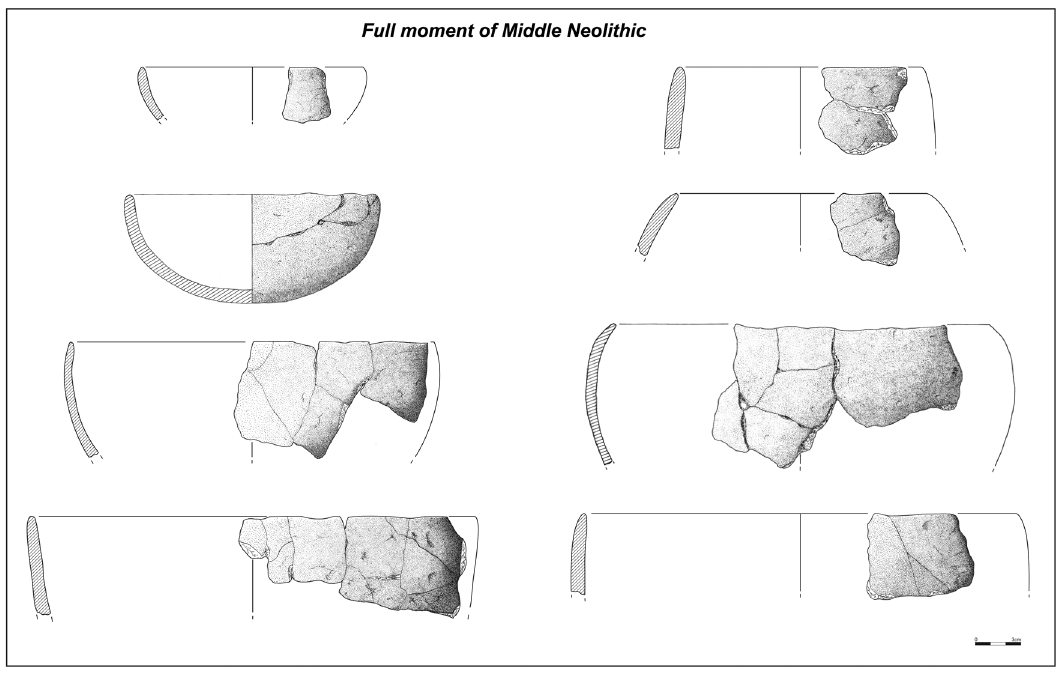
Figure 8: Full Moment of Middle Neolithic ( ∼ 3700 – 3300 cal BC ) : Pottery from Moita do Ourives ( accordind to: Neves, 2018 )